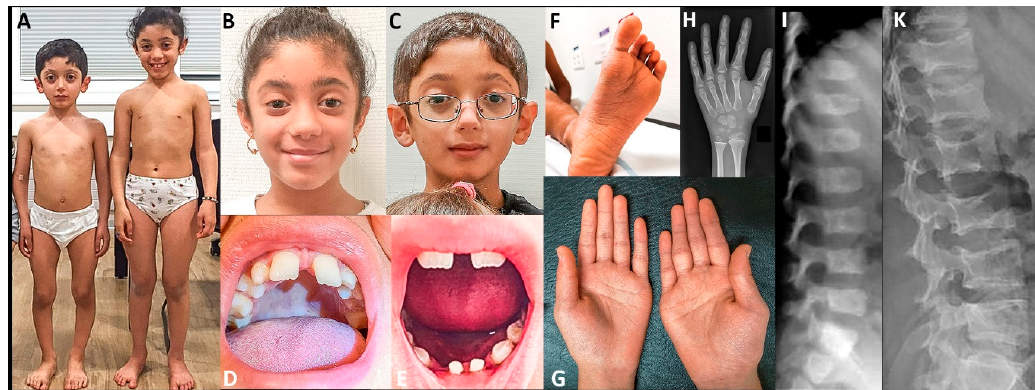
Figure 1. Clinical and radiographic findings. Individuals 5 (panels A and B) and 6 (panels A and C) at the age of eight and ten years. Panels D and E: missing upper incisives, and missing lower incisives with persistence of primary teeth in individuals 6 at age 9 years. Panel F: foot of individual 6 showing finely wrinkled skin and abnormally deep furrows. Panel G: Palmar aspects of the hands of individual 5 showing thin skin with increased number of fine wrinkles and mild thenar and hypothenar atrophy. Panel H shows the hand radiograph of individual 5 at age ten years. There is mild diaphyseal overconstriction of radius and ulna, metacarpals, and phalanges; bone maturation is roughly appropriate; overall, the changes are mild and non-diagnostic. Panels I and K: lateral spine radiographs of individual 3. At age 6 years, there is moderate platyspondyly. At age 15, the end plates have a marked concave